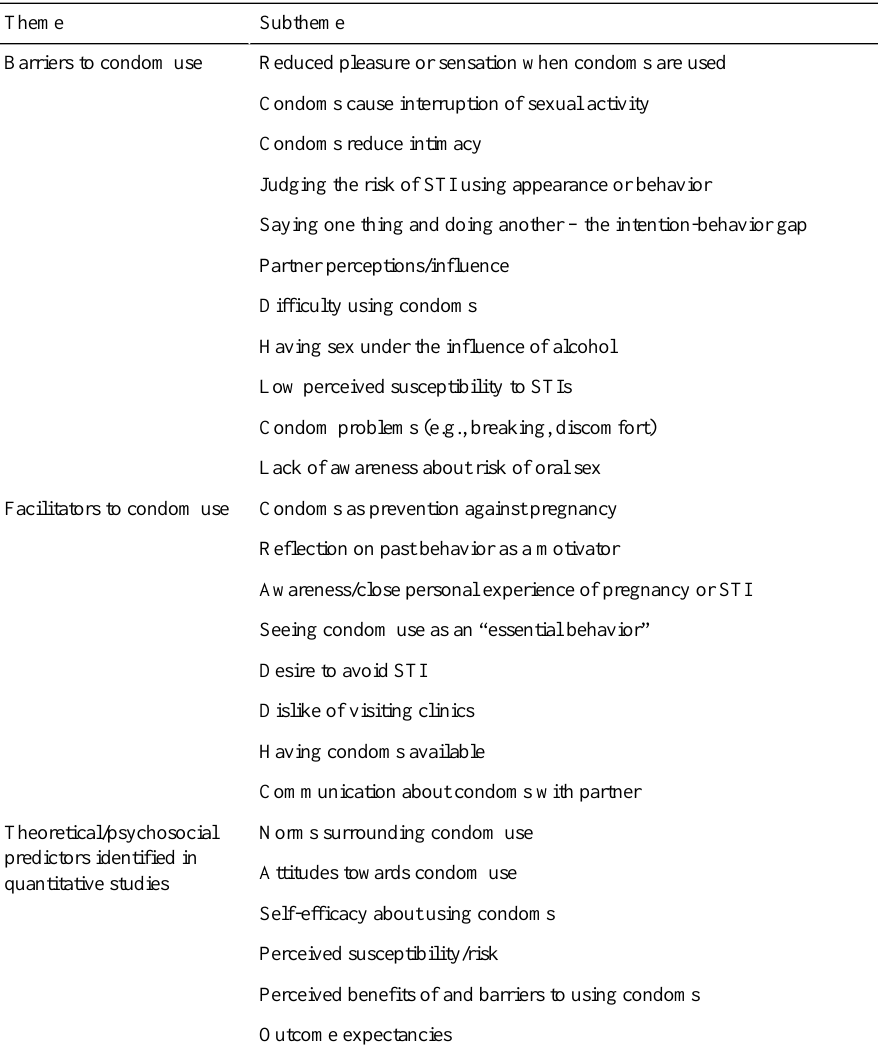
Table 1. Barriers and facilitators for condom use identified in the